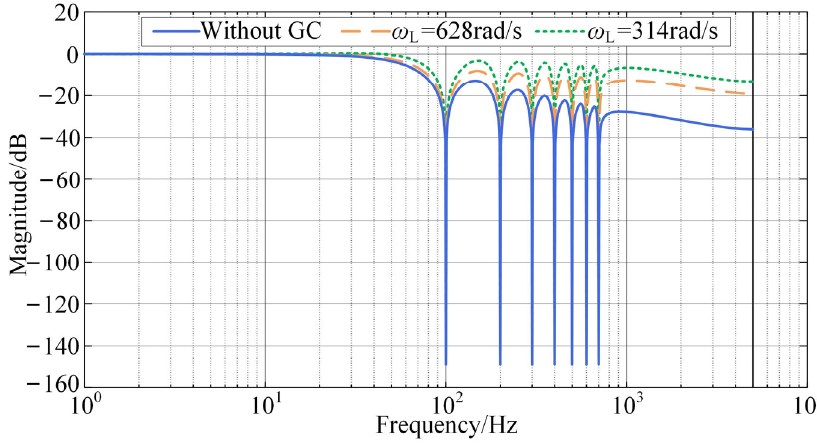
Figure 9. Bode diagram of SHEA with GC with different zero-related parameters ω L .